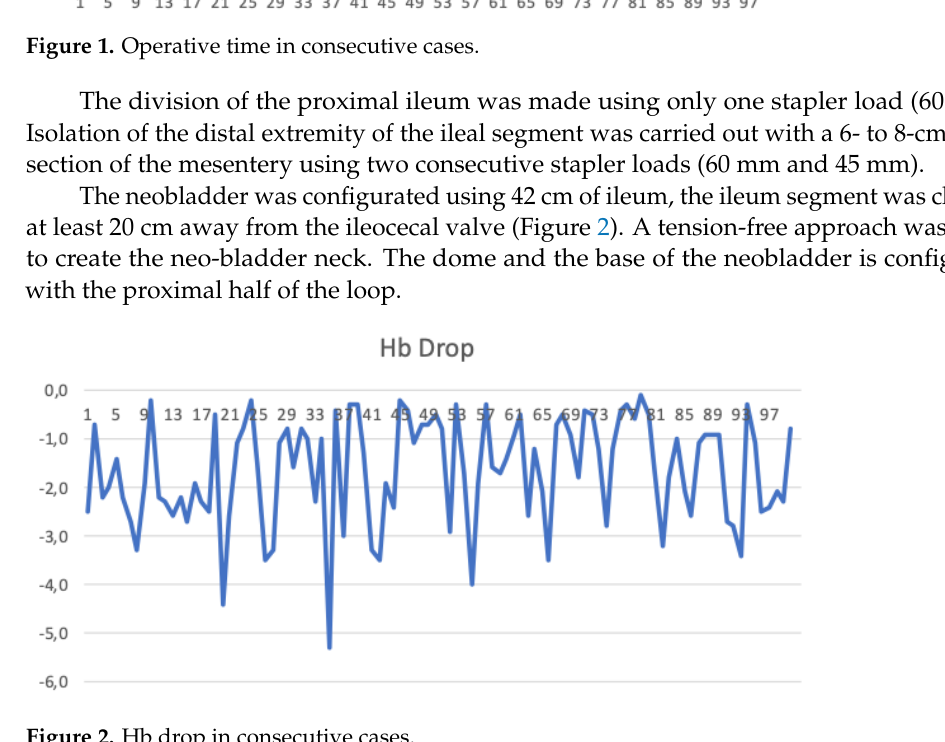
Figure 2. Hb drop in consecutive